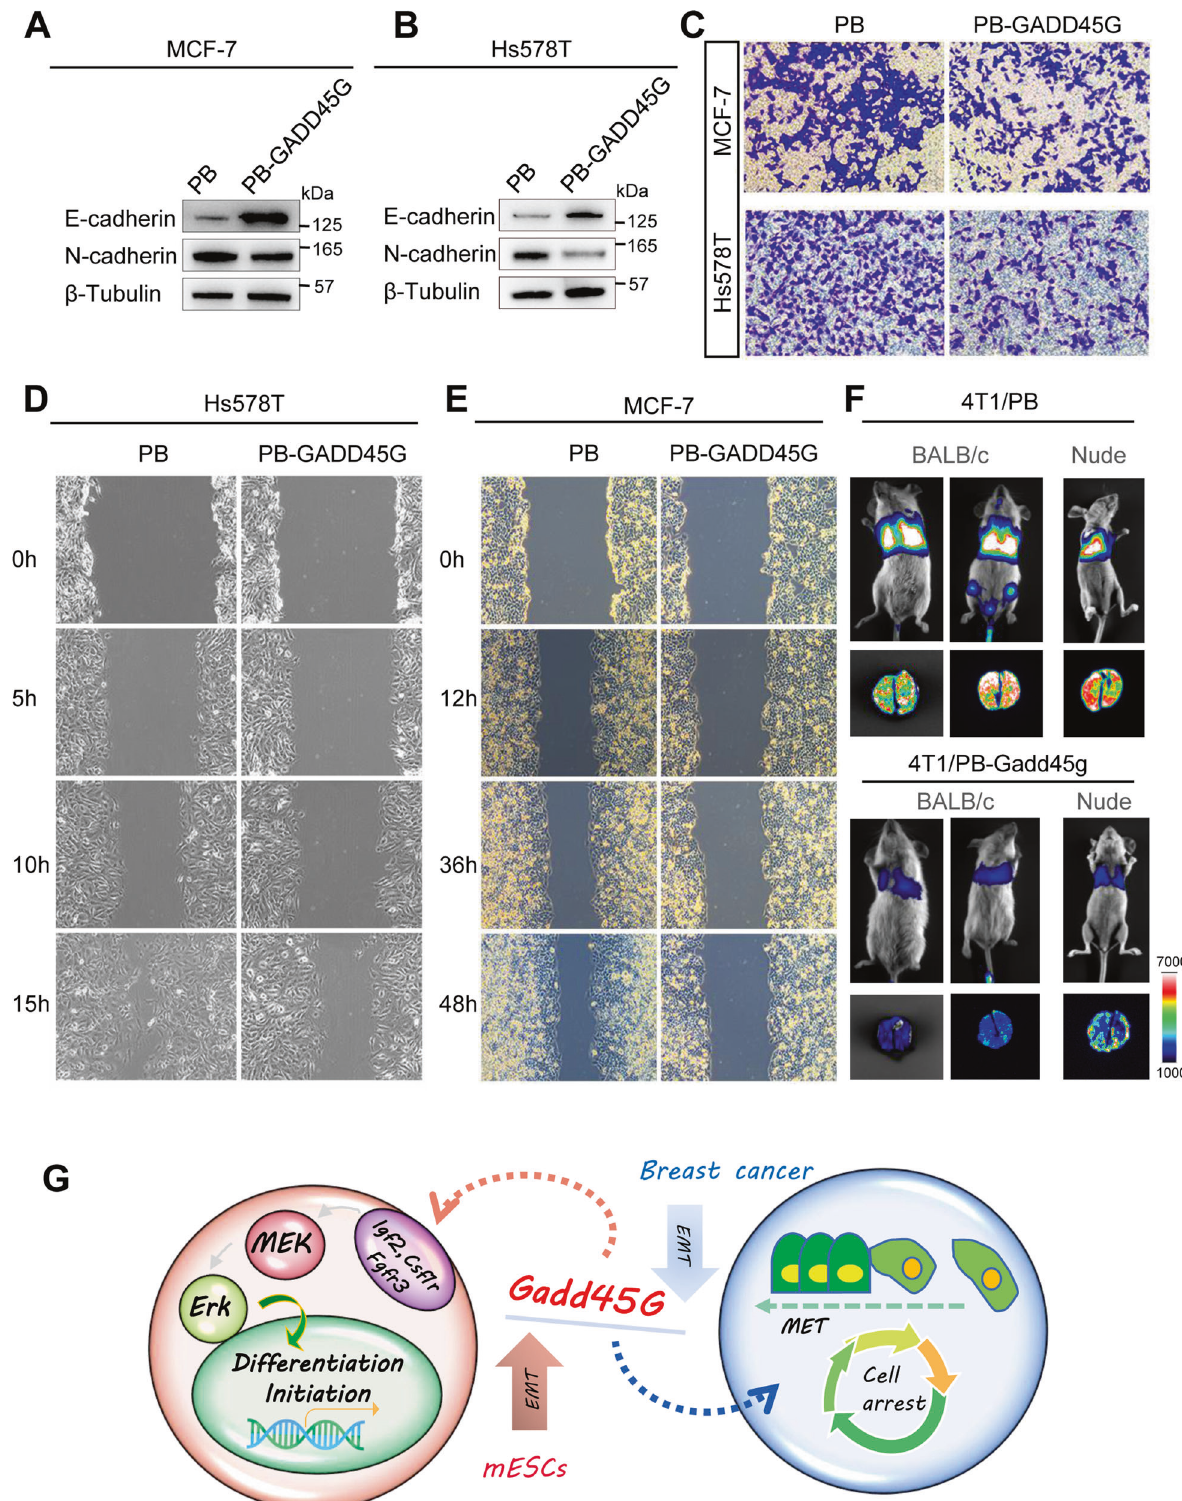
Fig. 6 Overexpression of GADD45G decreases the migration of breast cancer cells. A, B Western blot analysis of E-cadherin and N-cadherin levels in MCF7 or Hs578T cells overexpressing PB or PB-GADD45G. β -tubulin was used as a loading control. C Transwell experiments were used to analyze the migration ability of MCF7 and Hs578T cells overexpressing PB or PB-GADD45G. D, E The scratch experiments were used to evaluate the migration abilities of MCF7 or Hs578T cells overexpressing PB or PB-GADD45G. F Luciferase-tagged mouse breast cancer 4T1 cells stably expressing PB or PB-Gadd45g were transplanted in mice. Metastasis was imaged using Tanon-5200Multi system. G Schematic diagram of the role of Gadd45g in mouse ESCs and breast cancer cells. Overexpression of Gadd45g triggers ESC differentiation via activation of MAPK signaling, and suppresses the proliferation and invasion of breast cancer cells in vivo and in vitro.